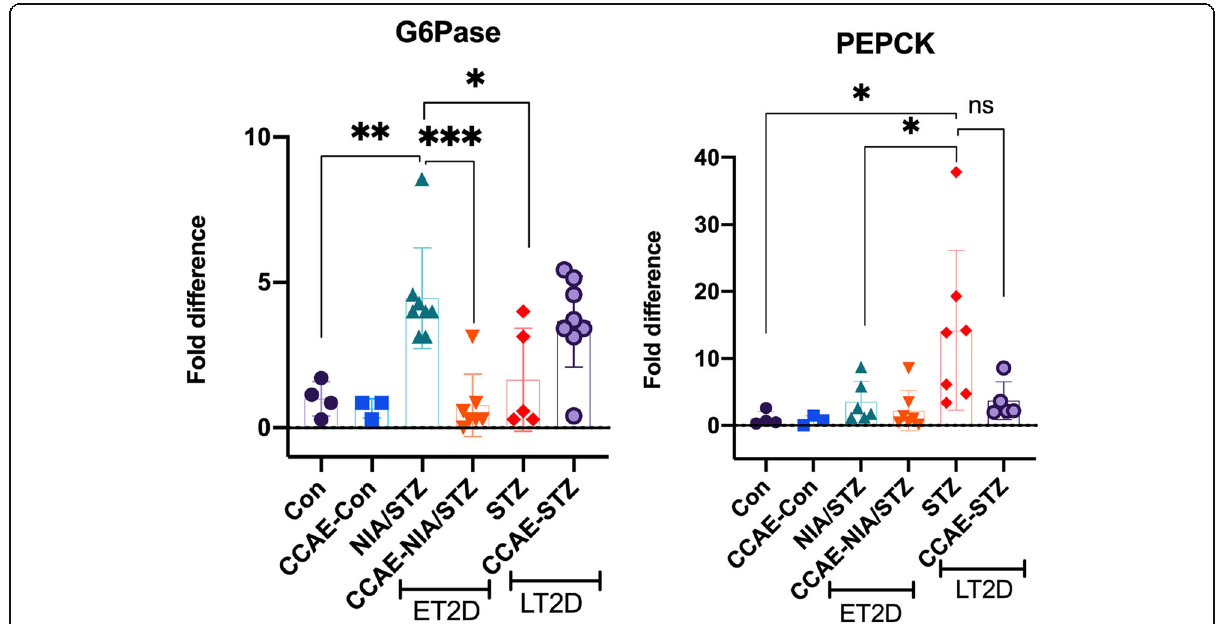
Fig. 4 Hepatic PEPCK and G6Pase gene expression on day 28. After diabetes induction, there was a significant (~ 5 fold) rise in the mRNA levels of G6Pase ( p = 0.005) and a slight insignificant rise of PEPCK in ET2D (NIA/STZ group, p = 0.987); treatment with CCAE (for 28 days) resulted in a significant decrease in the expression of G6Pase ( p = 0.003). In LT2D, the expression of PEPCK increased significantly (~ 12 folds) after induction of diabetes ( p = 0.023) and did not decrease significantly after CCAE treatment ( p = 0.072). Con: nondiabetic control, CCAE-Con: nondiabetic control treated with CCAE, NIA/STZ: early-stage diabetic group, CCAE-NIA/STZ: the early-stage diabetic group treated with CCAE, STZ: late-stage diabetic group, CCAE-STZ: the late-stage diabetic group treated with CCAE. We used non-parametric tests to compare the variables between independent samples, followed by Mann-Whitney Test. We presented the data as the mean ± SEM. **, p < 0.01; ***, p < 0.001. Every bar is the average of